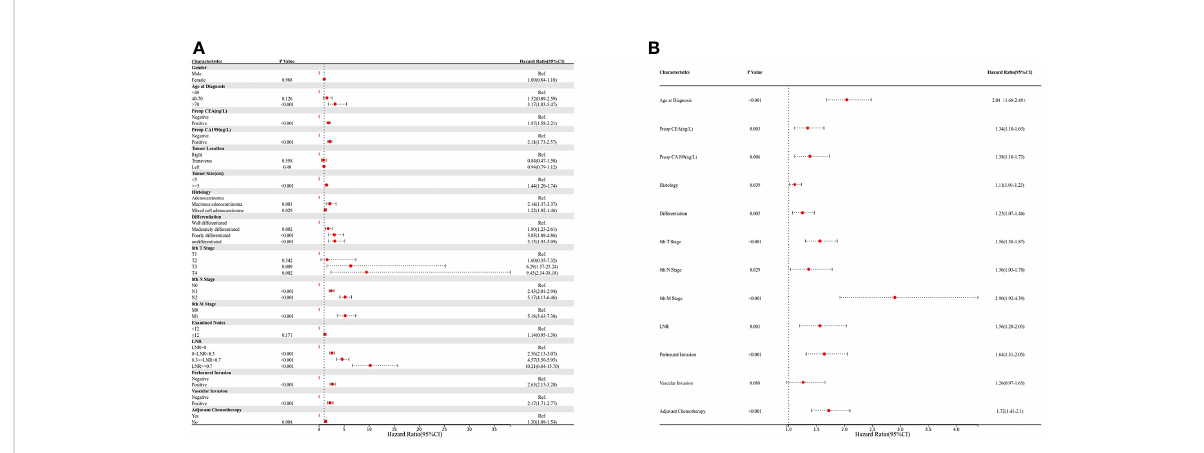
FIGURE 2 Univariate and multivariate Cox regression analyses; (A) univariate analysis; (B) multivariate